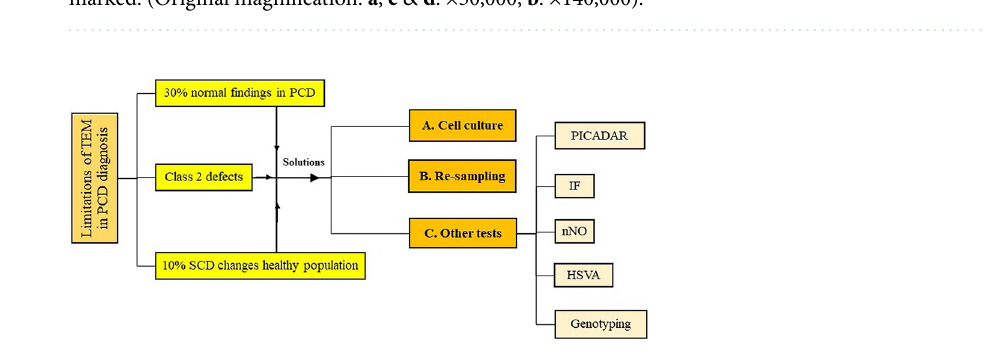
Figure 7. Challenges of PCD diagnosis and possible solutions. TEM transmission electron microscopy, PCD primary ciliary dyskinesia, SCD secondary ciliary dyskinesia, PICADAR PrImary CiliAry DyskinesiA Rule, IF immunofluorescence, nNO nasal nitric oxide, HSVA high-speed video